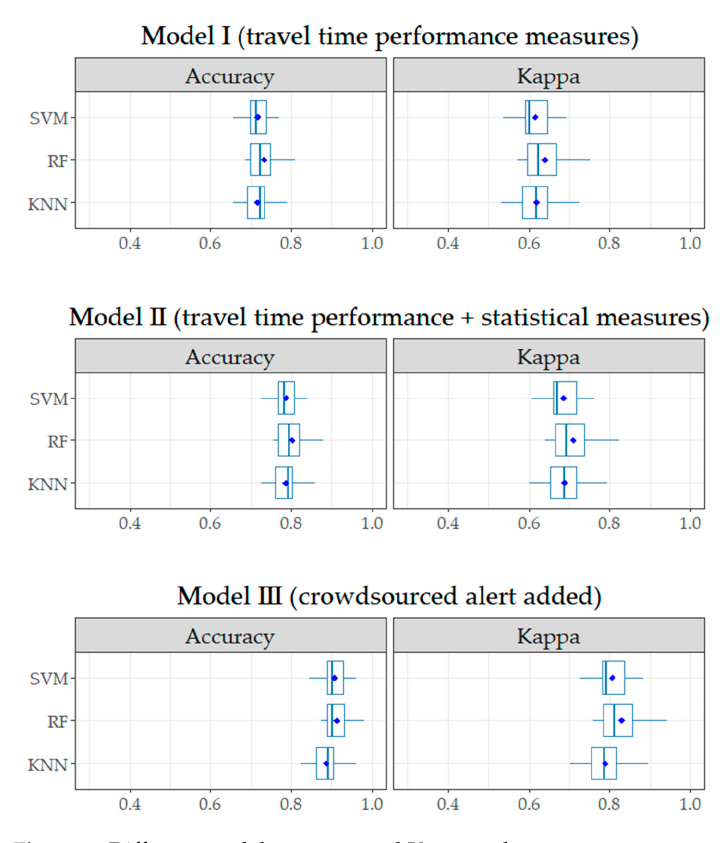
Figure 5. Different model accuracy and Kappa values.